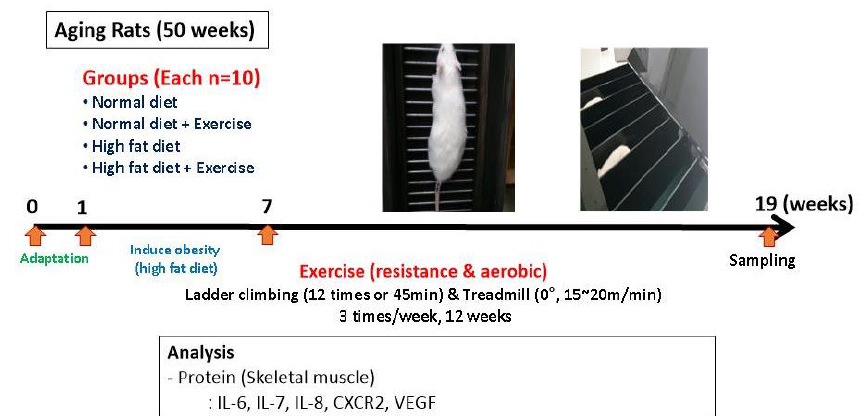
Figure 1. Schematic of experimental design.